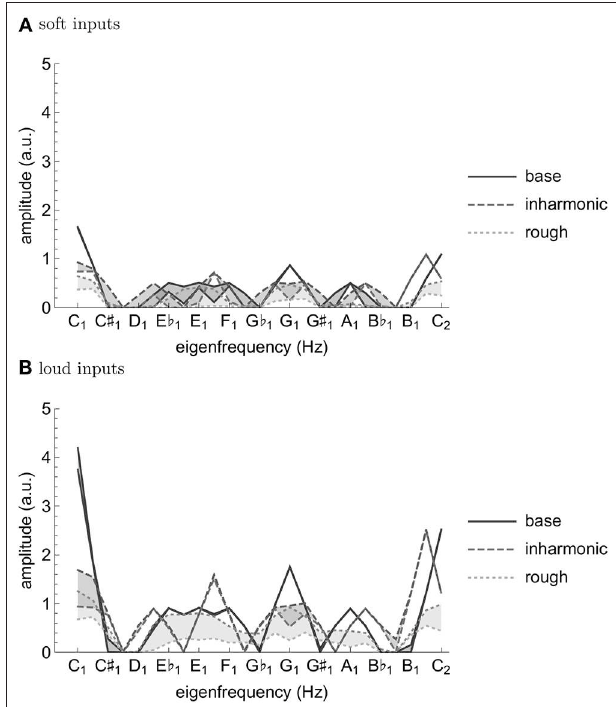
FIGURE 6 | Minima and maxima of the oscillator amplitude traces from simulations with soft/low-amplitude input corresponding to Figure 1 (A) and loud/high-amplitude input corresponding to Figure 2 (B) with the first 20 s dropped to attenuate the effect of the same initial conditions. Incidentally, note the similarities between Figure 6 and the major key profile from Krumhansl and Kessler [